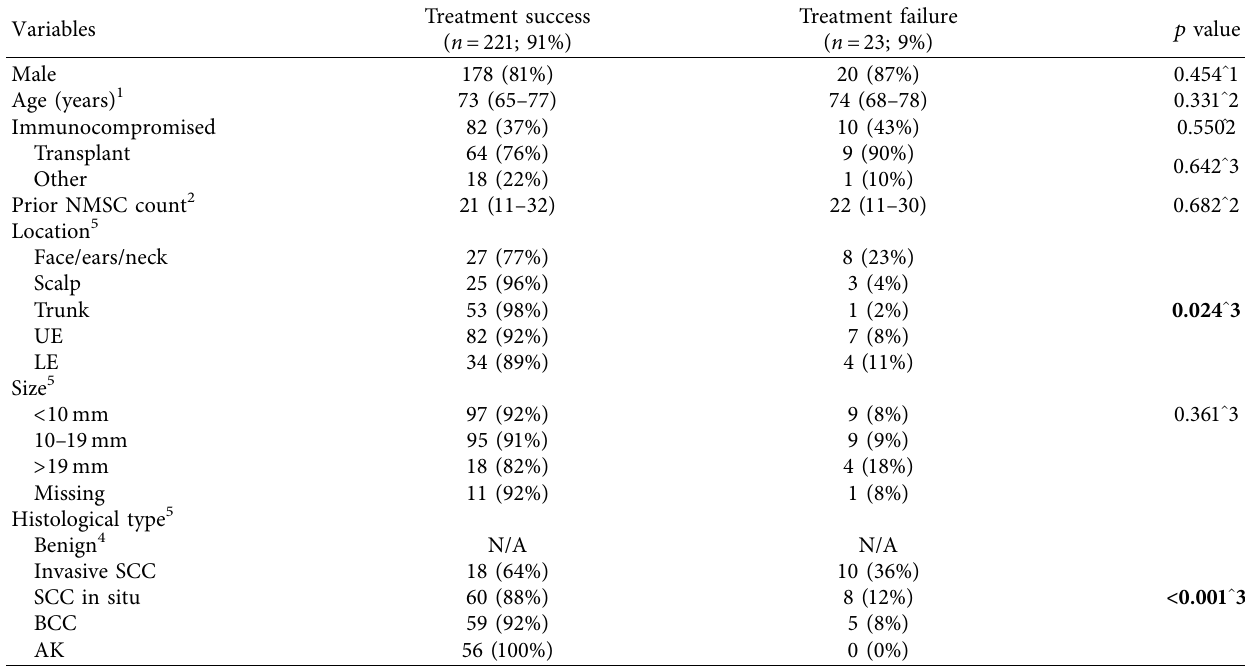
Table 3: Factors associated with treatment failure among 244